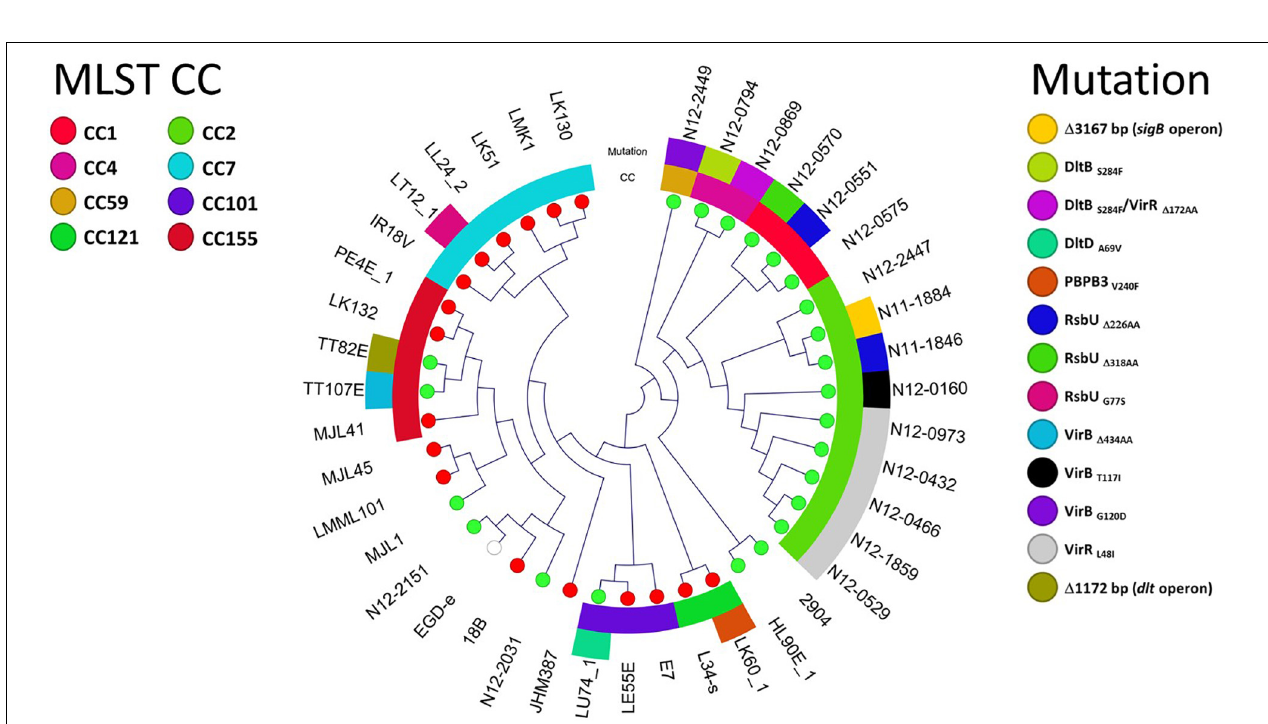
FIGURE 5 | Overview of 40 L. monocytogenes strains showing the highest nisin resistance ( (cid:49) PAUC < 10%; 17 strains) and sensitivity ( (cid:49) PAUC > 90%; 23 strains). Cladogram showing the phylogenetic relationship of the strains based on core genome SNPs. The MLST CCs and nisin response gene mutations detected among the nisin resistant (red leaf nodes) and sensitive (green leaf nodes) strains are also